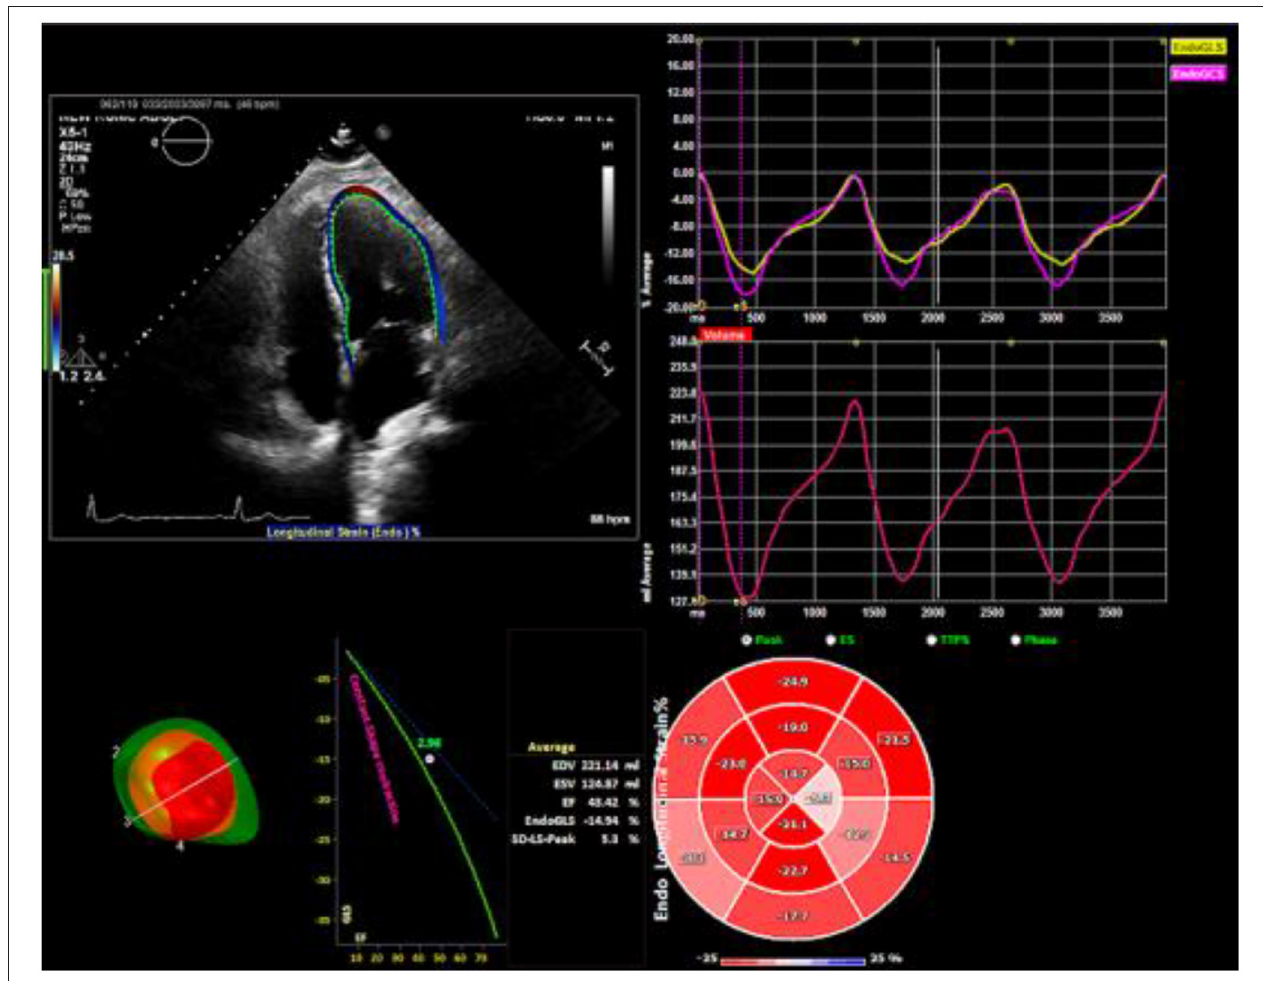
FIGURE 2 | Two-dimensional speckle tracking echocardiography analysis. Strain curves and a color-coded 16-segment bull’s eye plot are presented. Color lines indicate regional strain. Values of longitudinal strain are negative (sign –). Endocardial border tracing in apical four-chamber view can be achieved automatically. Global longitudinal strain (GLS) can be calculated from standard apical 4-, 2-, and 3- chamber